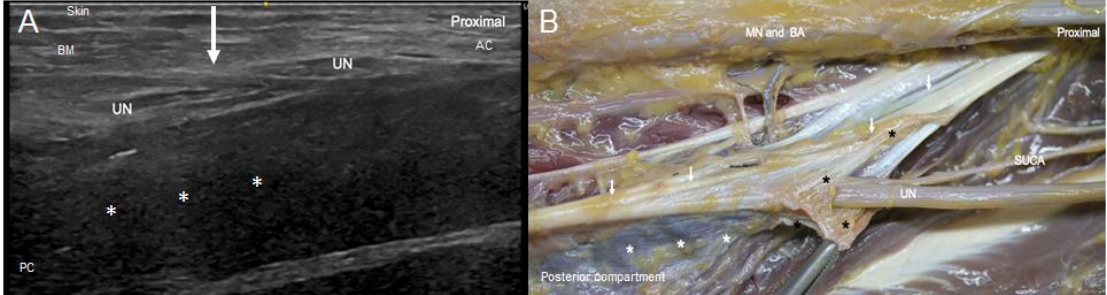
Figure 2. ( A ) US image in longitudinal axis of the ulnar nerve (UN) at the middle third of the arm. IMS is marked with a white arrow. The skin (SK), the anterior compartment (AC) with brachial muscle (BM), and the posterior compartment (PC) with the triceps brachii muscle (white asterisks) are indicated. The hipoechogenicity of this last muscle is due to the position of the probe to focus the UN and the septum. ( B ) Anatomical view of the UN crossing beneath the medial IMS (arrows), accompanied by the superior ulnar collateral artery (SUCA). We used a surgical clamp to pull the collagen fibres that make up the IMS (black asterisks). It is shown that, once in the posterior compartment, the UN remained covered by the medial head of triceps brachii muscle (white asterisks), which was inserted into the whole length of the